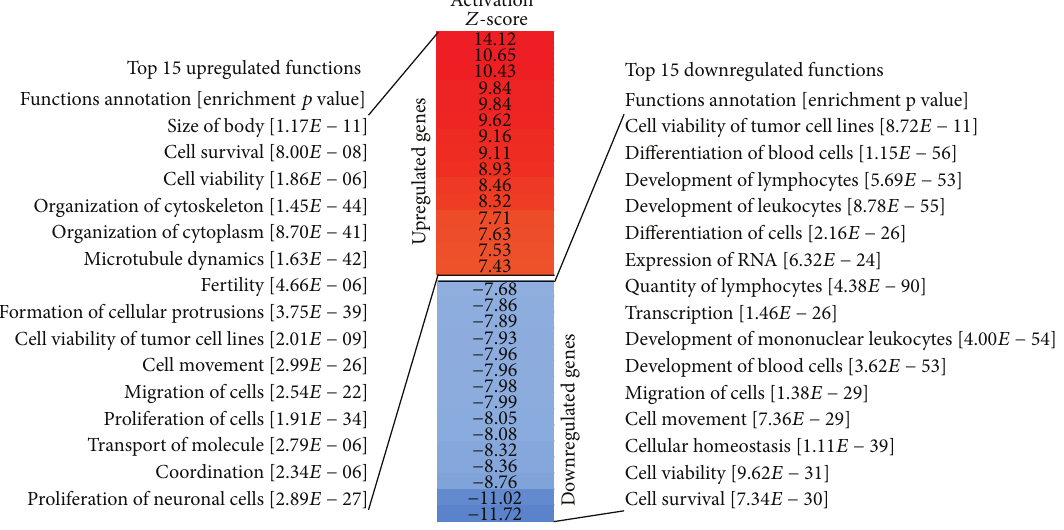
Figure 5: Graphical presentation of the top 15 upregulated and downregulated cellular functions found to be enriched during LCL-to-iPSC